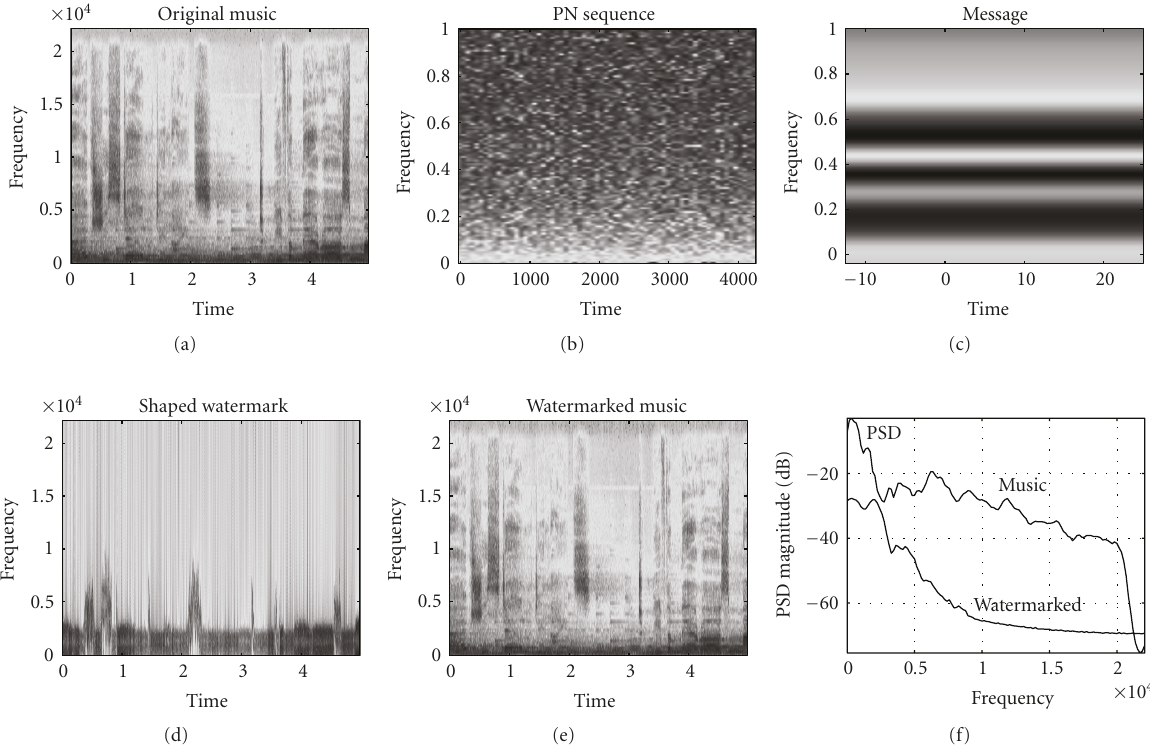
Figure 18: Overview of watermarking procedure for POP voiced segment (“viorg.wav”). Several robustness tests based on StirMark